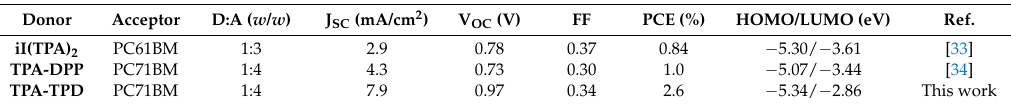
Table 3. Comparison of photovoltaic parameters for OSCs based on iI(TPA) 2 and TPA-DPP with those measured in this work based on TPA-TPD .